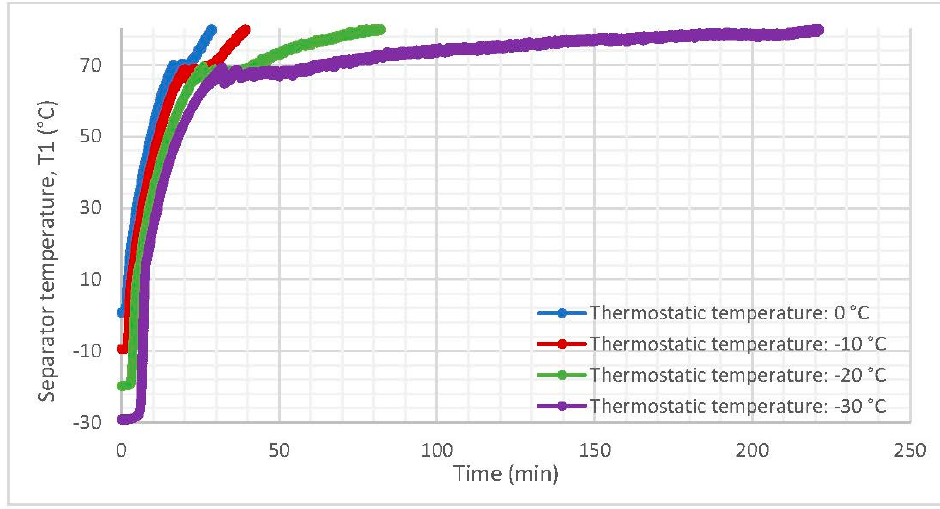
Figure 4. Temperature in the air/oil separator, acting also as lubricant tank, averaged over the two tests executed for the diverse thermostatic temperatures.